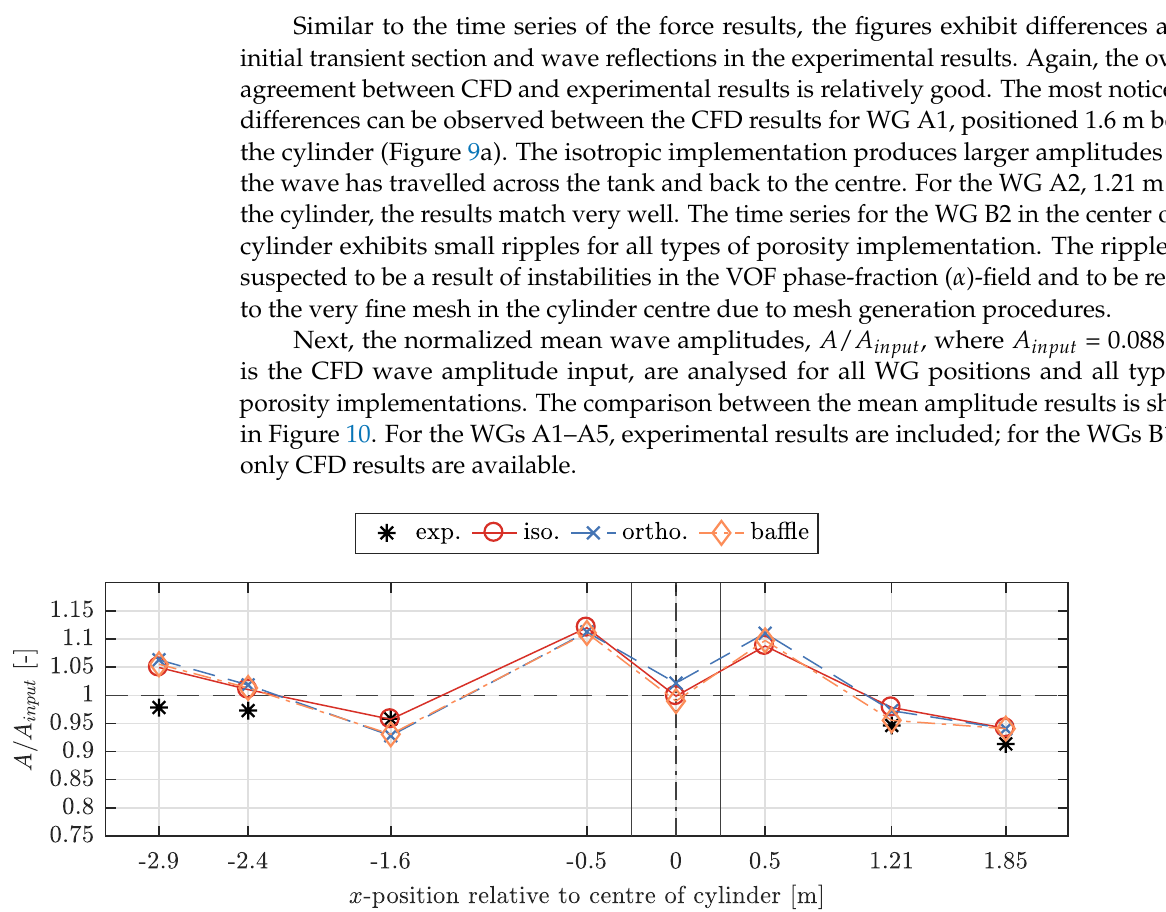
Figure 10. CFD and experimental results of the normalized mean wave amplitudes, A / A input , for all WGs before and after the cylinder. The position of the center of the cylinder is indicated with a dashed vertical line and the cylinder front and back are indicated with solid vertical